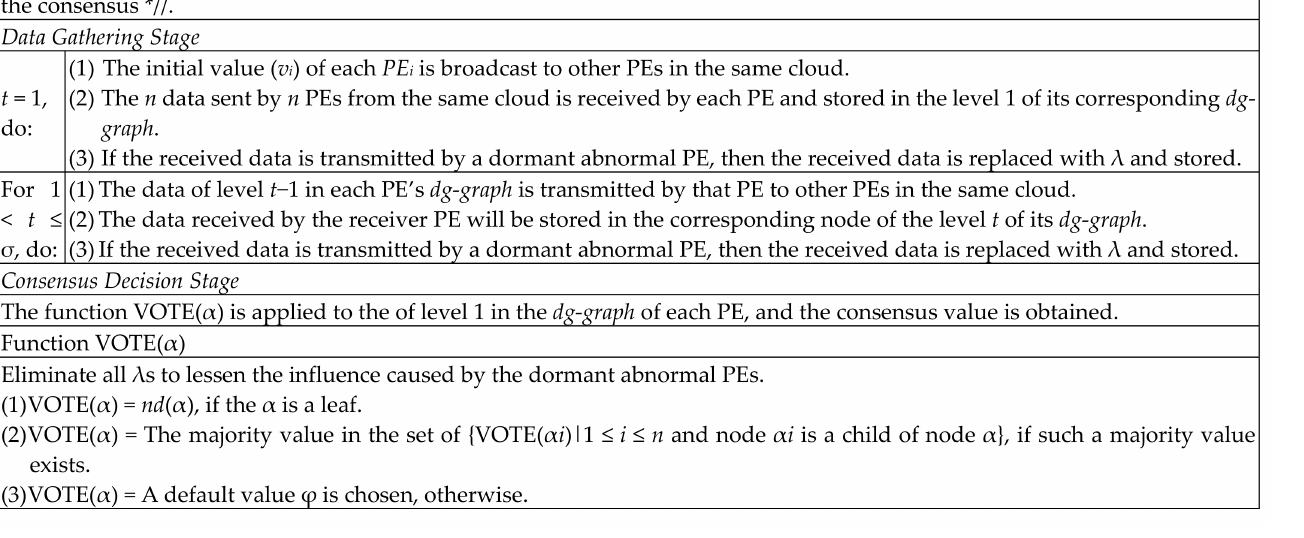
Figure 4. The proposed